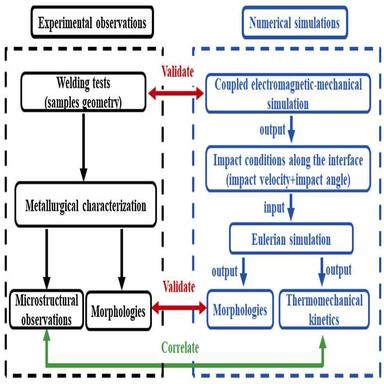
Flowchart showing various experimental and numerical steps in this study.